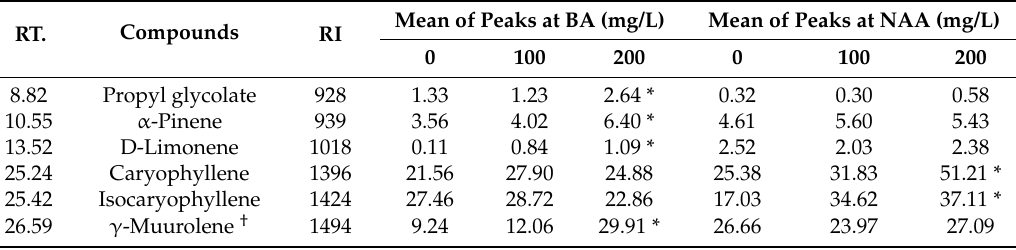
Figure 3. Volatile organic compounds collected from Floribunda flowers after the application of BA ( A ) and NAA ( B ), the red dots represent the volatile compounds which were significantly ( p < 0.05) different to the total collected volatile compounds. PCA analyses were used with one-way ANOVA. Table 1. Identification of VOCs that differed significantly ( p ≤ 0.05) between flowers of Floribunda rose after being treated with different concentrations of BA and NAA. RT.